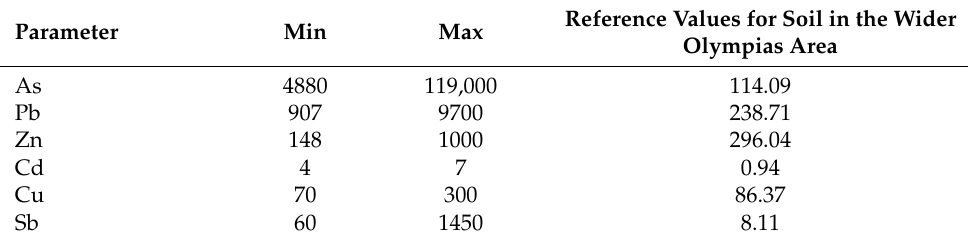
Figure 3. Soil sampling grid at the old arsenopyrites concentrate storage area (former METBA plot) before remediation .